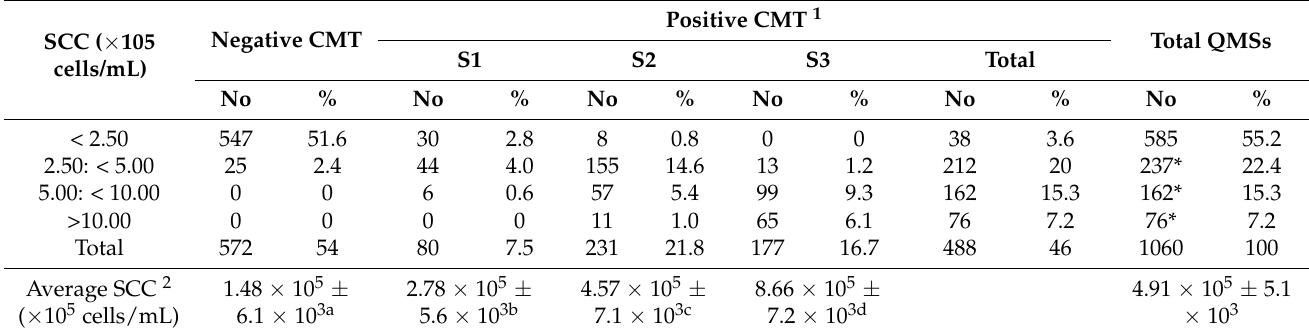
Table 2. Frequency distribution of SCC in relation to CMT scores in the examined QMSs.